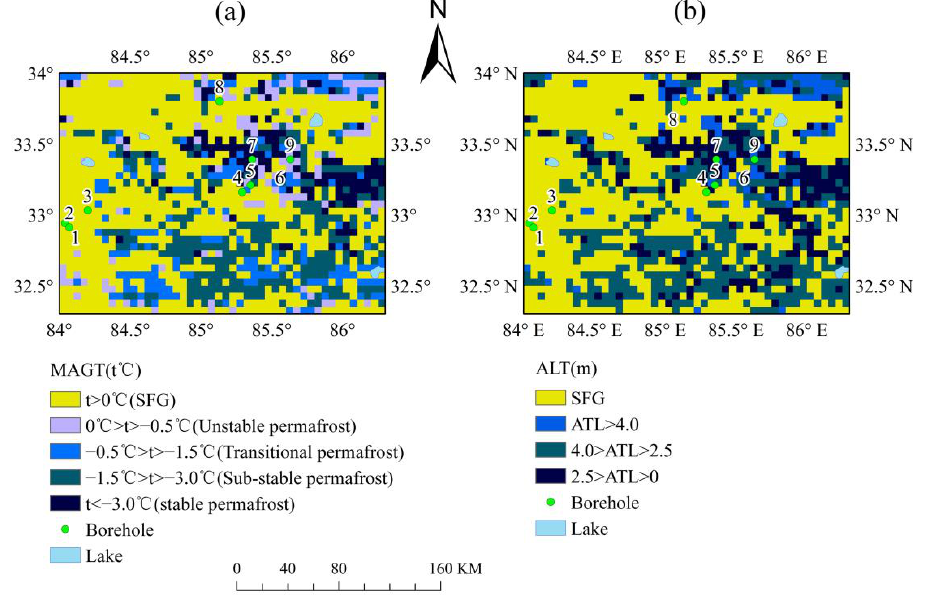
permafrost, accounting for 48.3% of the total area, while SFG is 20.0 × 103 km 2 , accounting for 51.2% (Figure 2b). The Kappa coefficient for Figure 3b,d is 0.48, indicating that the two maps moderately agree with each other. The discrepancy of permafrost distribution in the two maps is 2.6% and mainly lies in areas with mixed vegetation cover, where the altitudinal limit of permafrost may be influenced by the distribution of vegetation coverage.